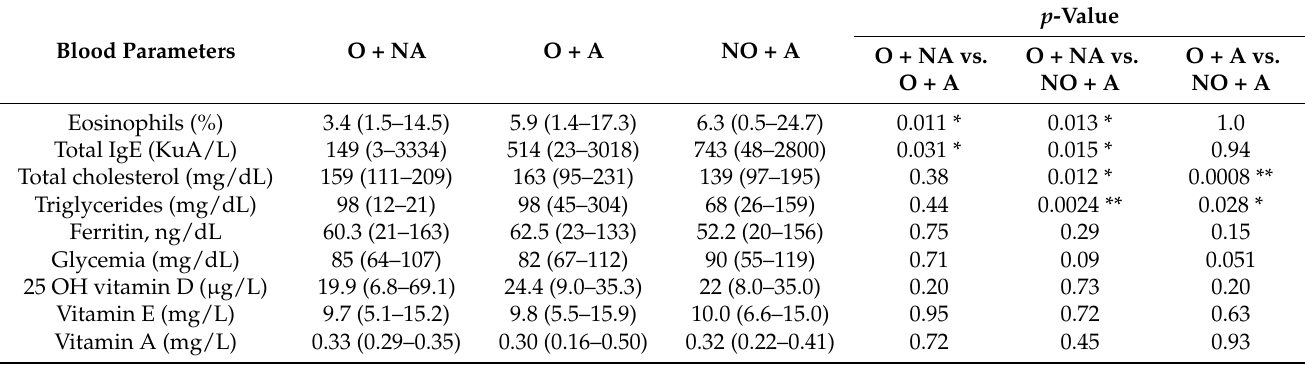
Table 3. Biochemical profile of the study population. * = p < 0.05, ** p < 0.005.